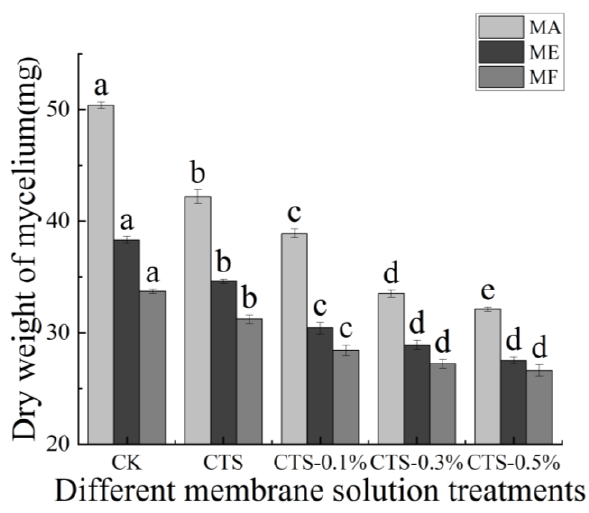
Figure 4. Effect of different concentrations of composite membrane solution on dry weight of mycelium. The bars on the columns indicate standard deviation. Different letters indicate significant differences ( p < 0.05) within an experiment (marked with letters).